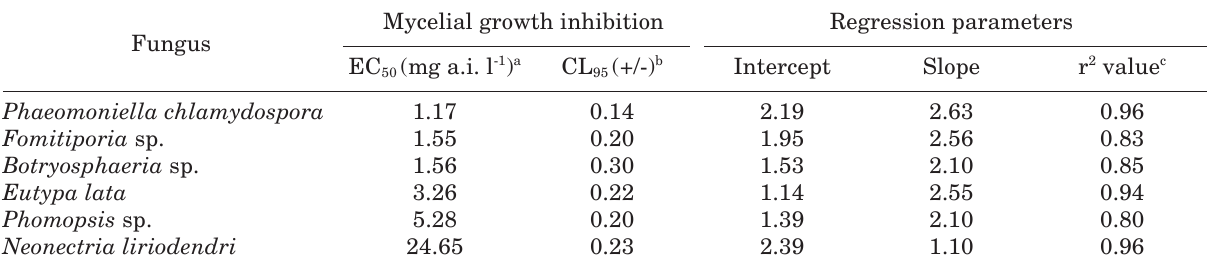
Table 3. Activity of chitosan against mycelial growth of different grapevine wood fungi assessed by regression